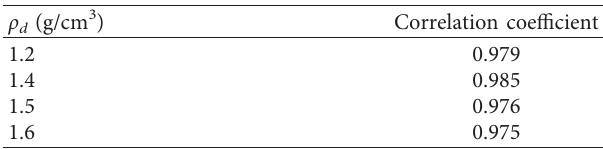
Figure 4: SWCC of loess with dry density of 1.2, 1.4, 1.5, and 1.6g/cm 3 at a temperature of (a) 5, (b) 15, (c) 25, and (d) 35. Table 2: Correlation